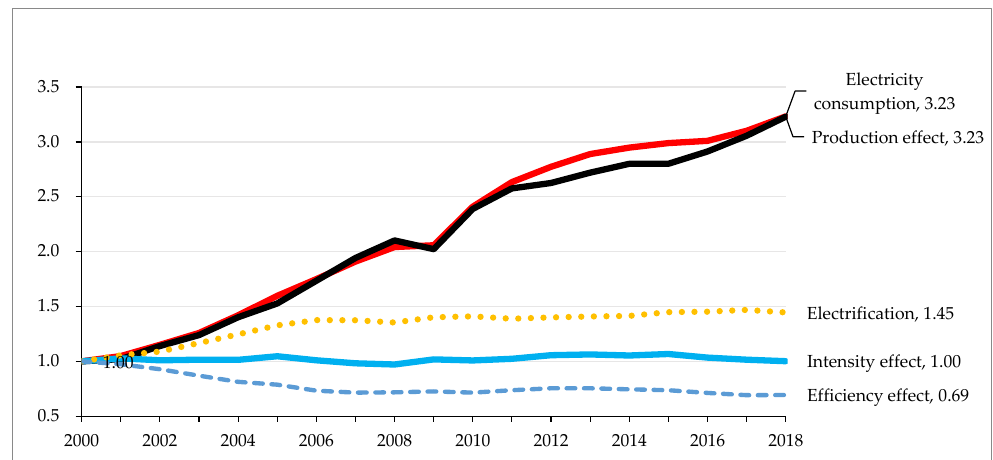
Figure A7. Nonferrous metal electricity consumption LMDI results (fixed base year, multiplicative).